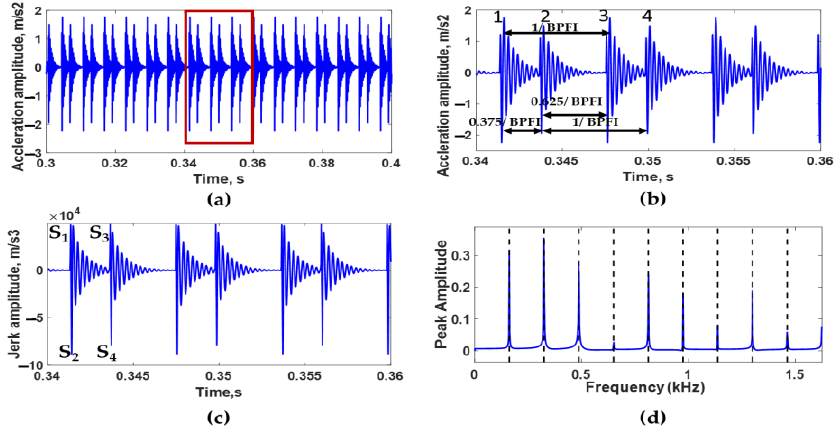
Figure 6. ( a ) Simulated acceleration signal of bearing with two dents on its inner race at 15°, ( b ) enlarged simulated acceleration signal between 0.34 s and 0.36 s, ( c ) simulated jerk signal in time domain, and ( d ) envelope spectrum of simulated acceleration signal.